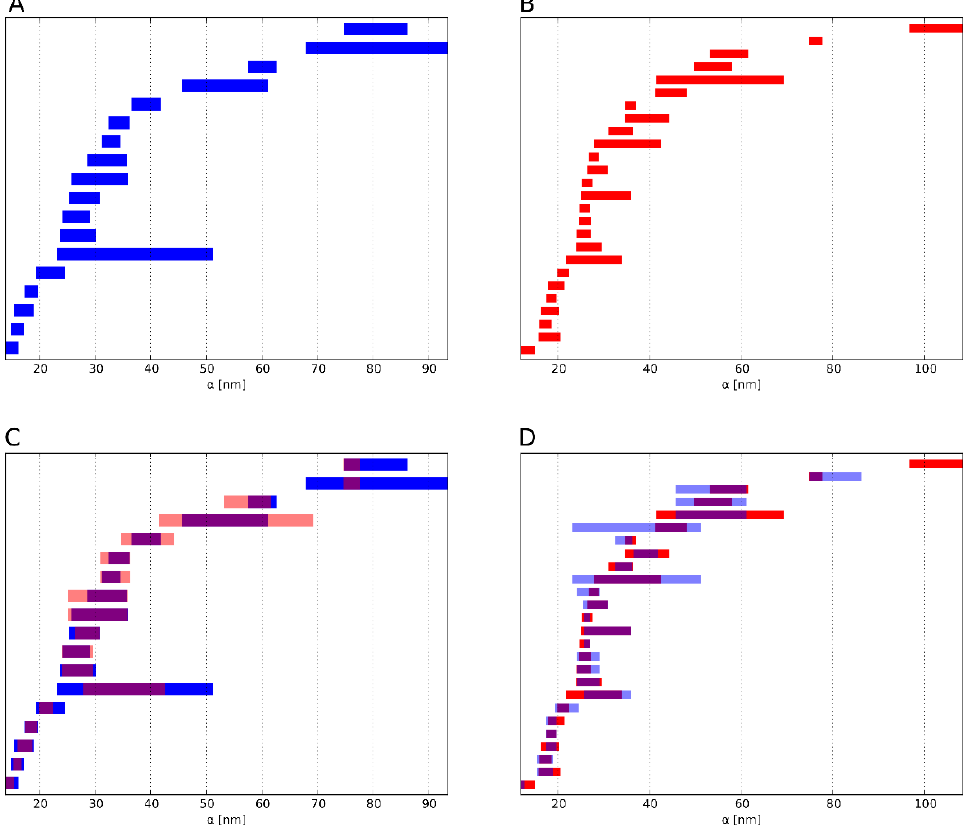
Figure 4. Example of the result of the barcode similarity measure. For each bar of barcode ( A ) (blue), the bar from ( B ) (red) is sought for which the Jaccard index is maximal. ( C ) The Jaccard index represents the extent to which two bars overlap (pink). This corresponds to C in equation S ( A , B ). These values are summed for each bar of A. ( D ) Analogously, for each bar from B the bar from A is sought, for which the Jaccard index becomes maximal. This corresponds to D in equation S ( B , A ). These values are in turn summed for the bar of B. The sum of these two subtotals is divided by the number of bars in both barcodes. The result S ( A , B ) or S ( B , A ) quantifies the similarity of the barcodes A and B in terms their overlap. Here, two barcodes of dimension 1 (holes) with a high similarity are depicted, i.e., the overlap of the two sets of barcodes is high. For comparison, we illustrate two dissimilar barcodes of dimension 1 in the supplementary material (see Figure S3).